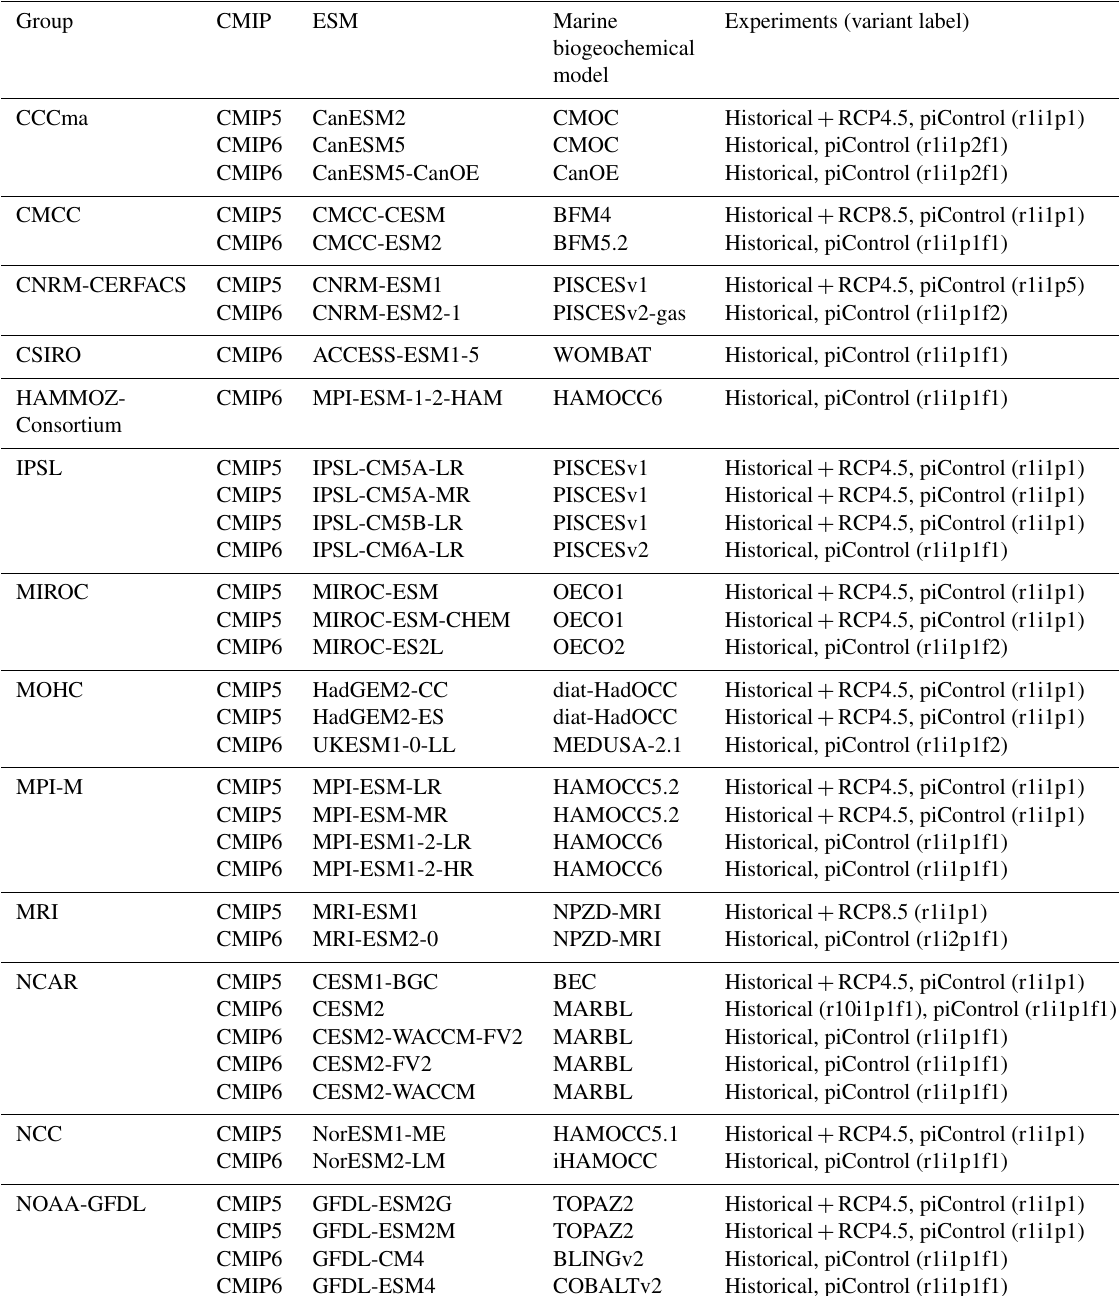
Table 1. Summary of the CMIP ESMs, their coupled marine biogeochemical models and the experiments assessed in this intercomparison.